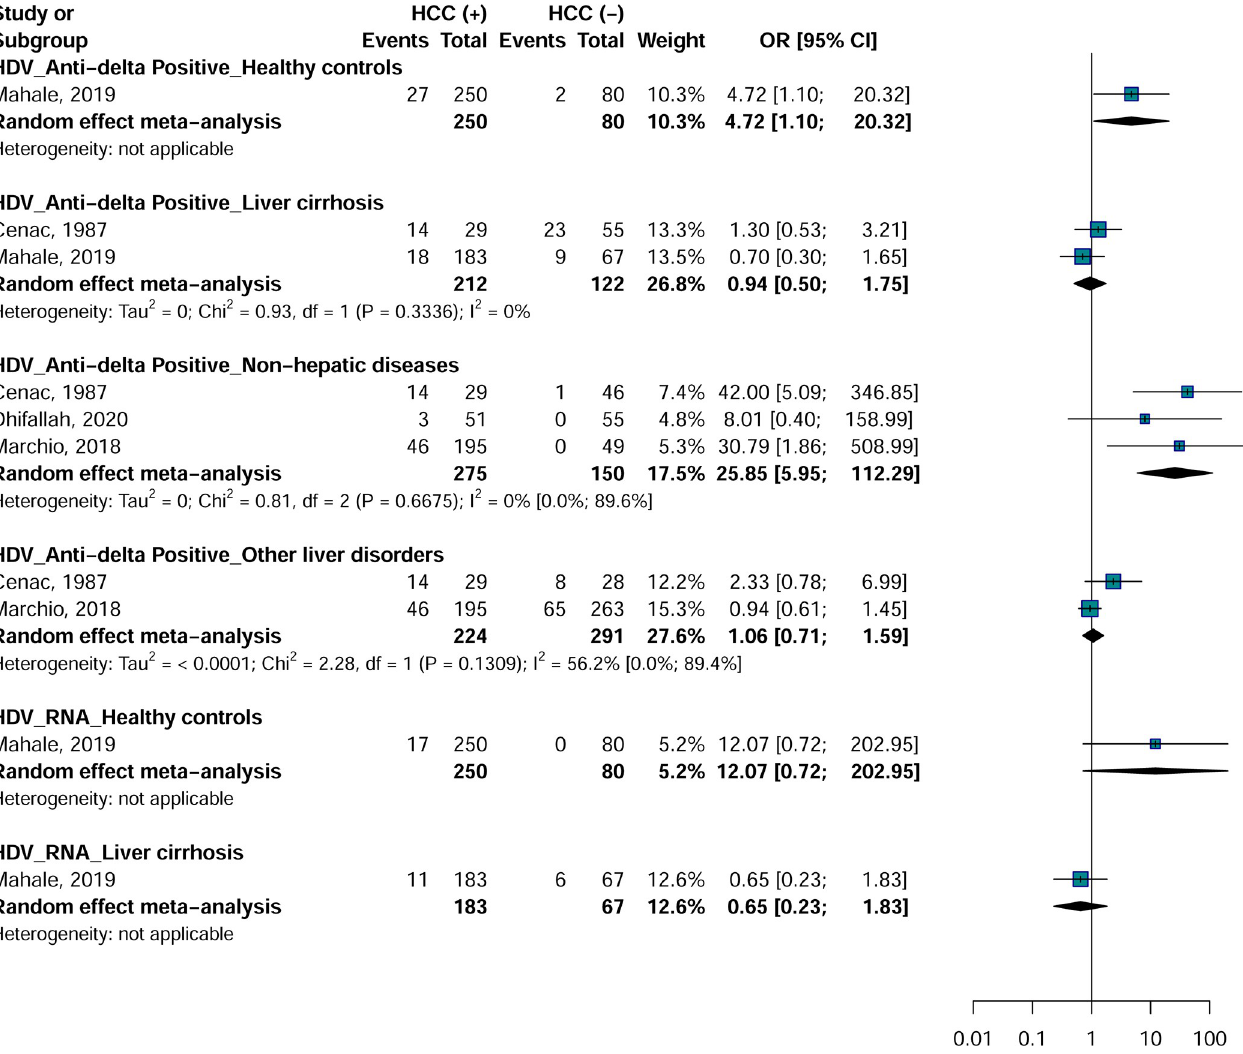
Fig 5. Association between Hepatitis D Virus infection and risk of hepatocellular carcinoma in